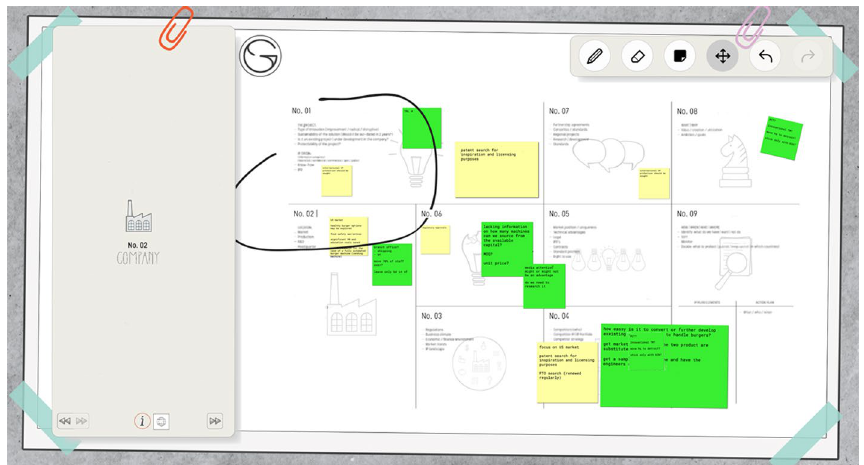
Fig. 1 Elements of the game—the gameboard, the card deck (on the left-hand side), and sticky notes in use. Players use the bottom left buttons to draw cards and the top right buttons to write, add sticky notes, and pan the